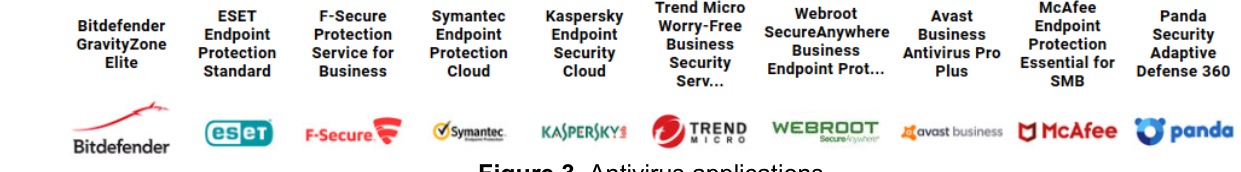
Figure 3. Antivirus